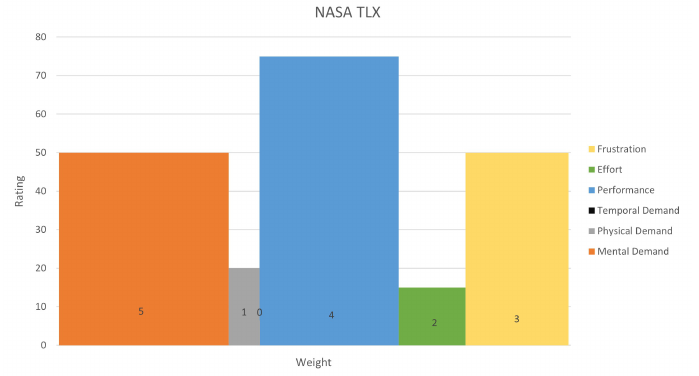
Figure 4. Participant’s workload (NASA TLX